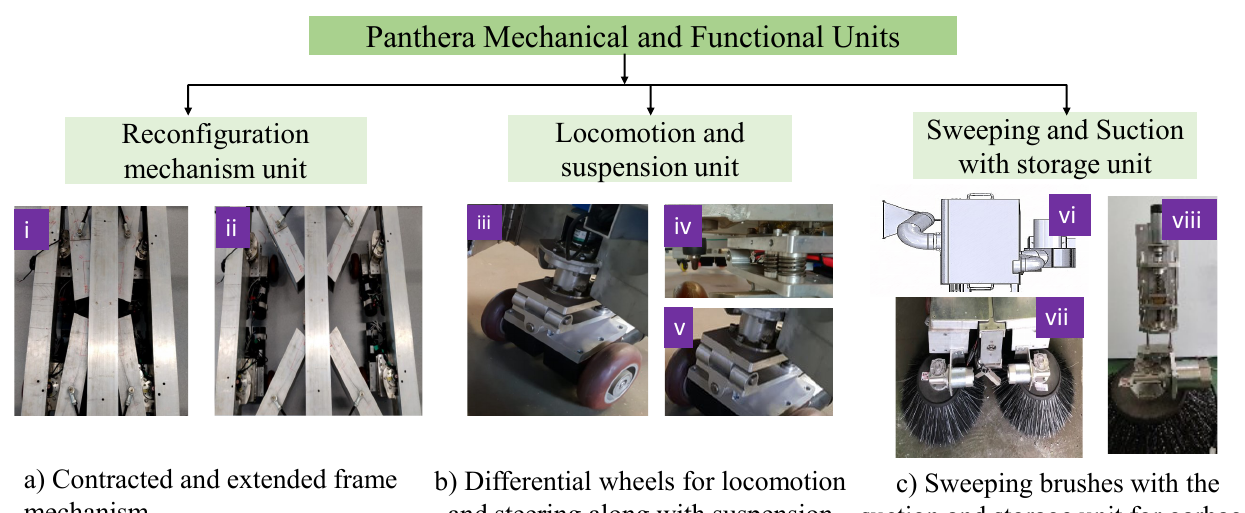
Figure 2. Mechanical and other functional components of Panthera.